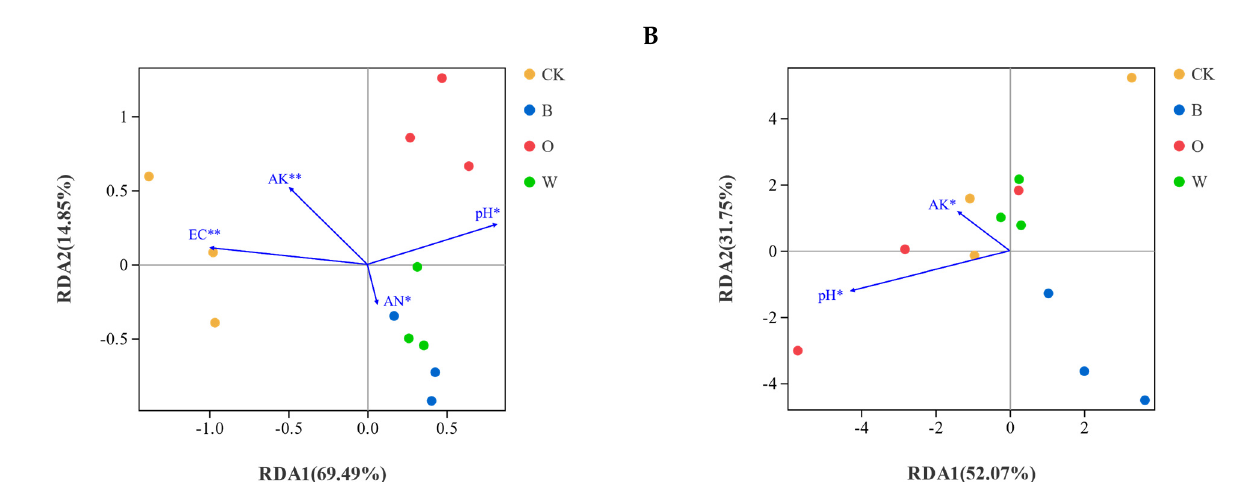
Figure 7. Redundancy analysis (RDA) of soil total bacterial ( A ) and fungal ( B ) community structures during the harvesting of the preceding crops. The environmental variables with statistical significance are presented by arrows. AK and AN indicate available K and available N, respectively CK represents Chinese cabbage continuous cropping, B, O, and W represent bean, potato onion, and wheat rotation, respectively. * p < 0.05; ** p < 0.01.